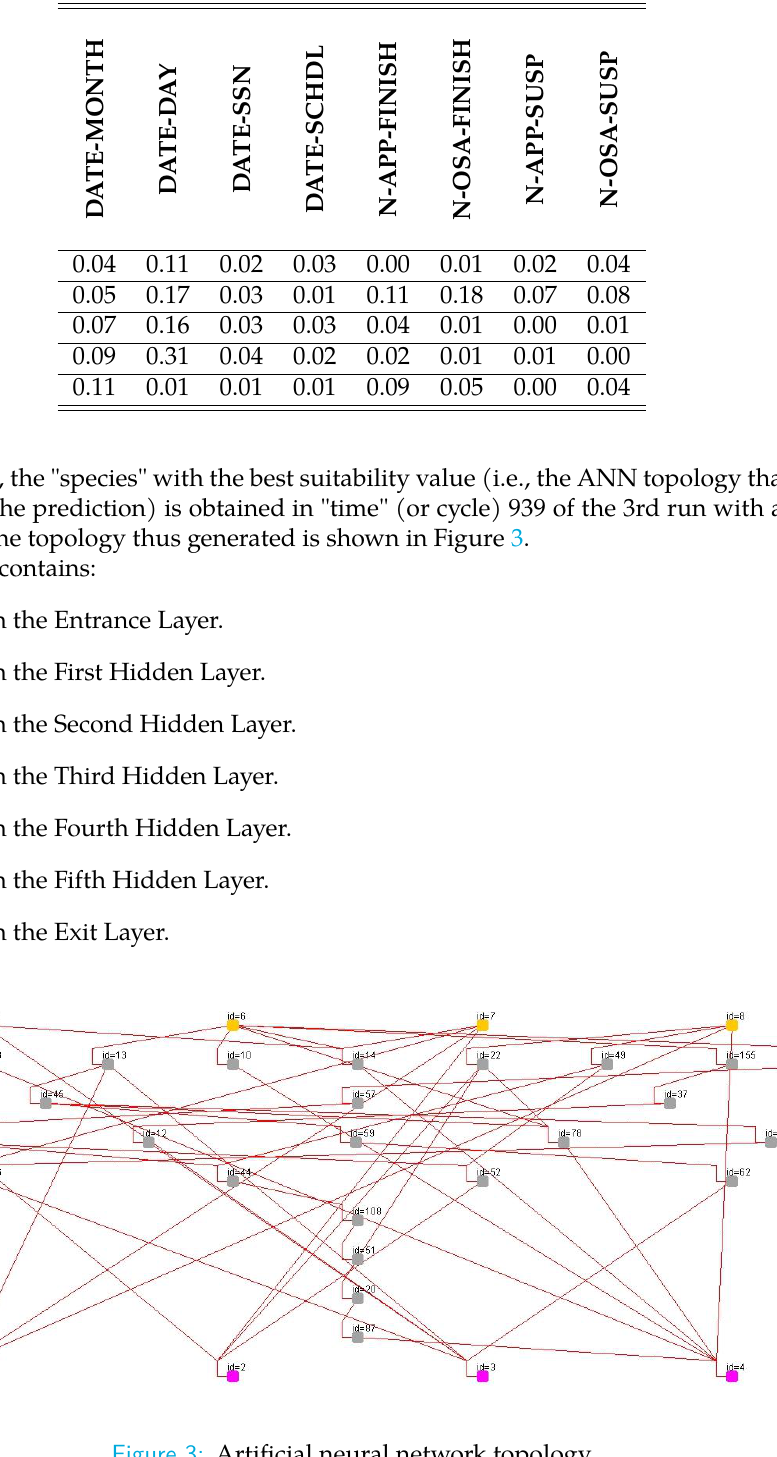
ParadigmPlus (2020)